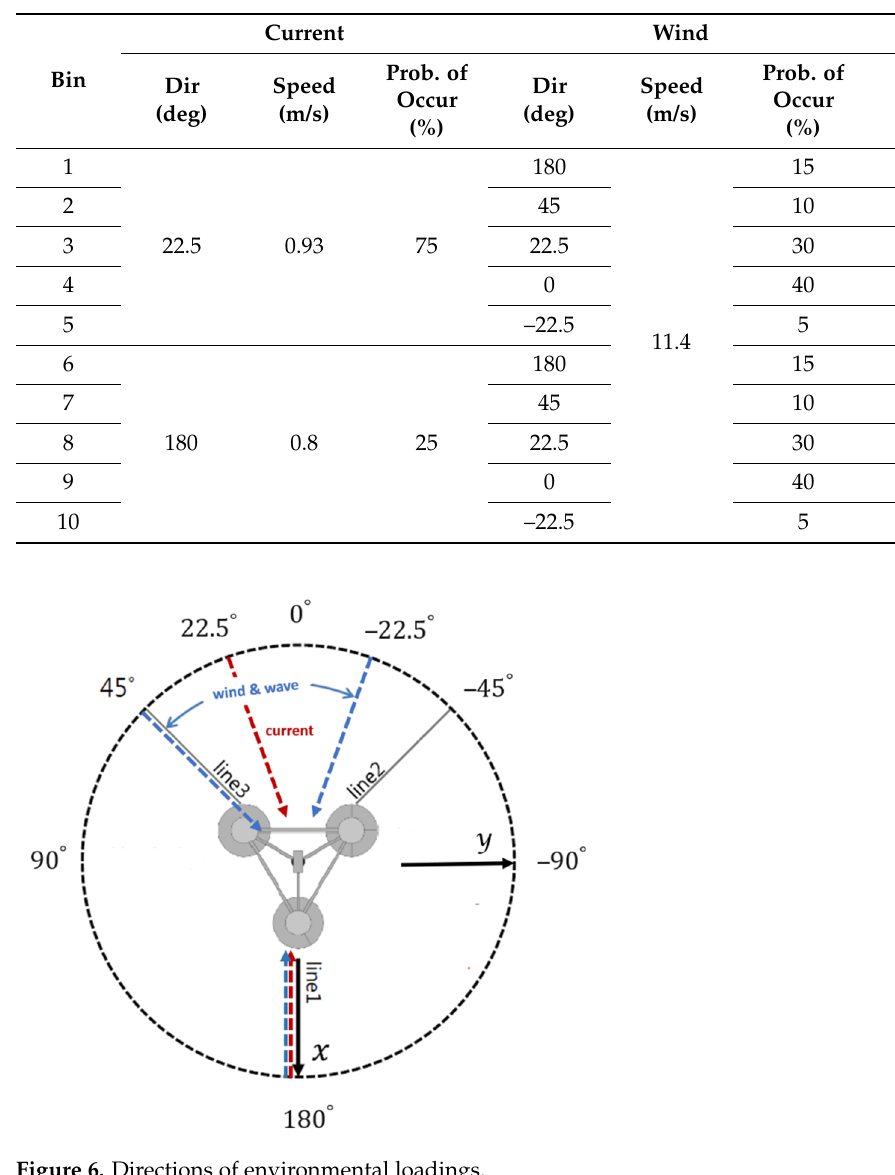
Table 5. Environmental bin according to current and wind conditions.